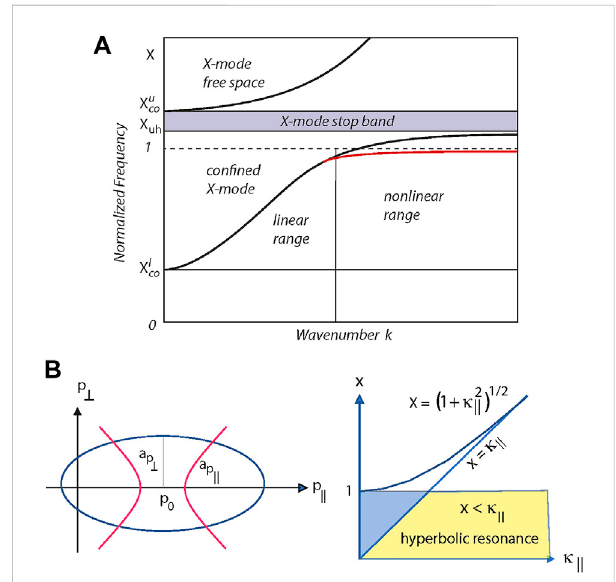
FIGURE 1 (A) Plasma-con fi ned X-mode dispersion relation in the auroral upward-current AKR source region (lower solid curve) under the prevalent low-density plasma condition ω e ≪ ω ce . The upper curve